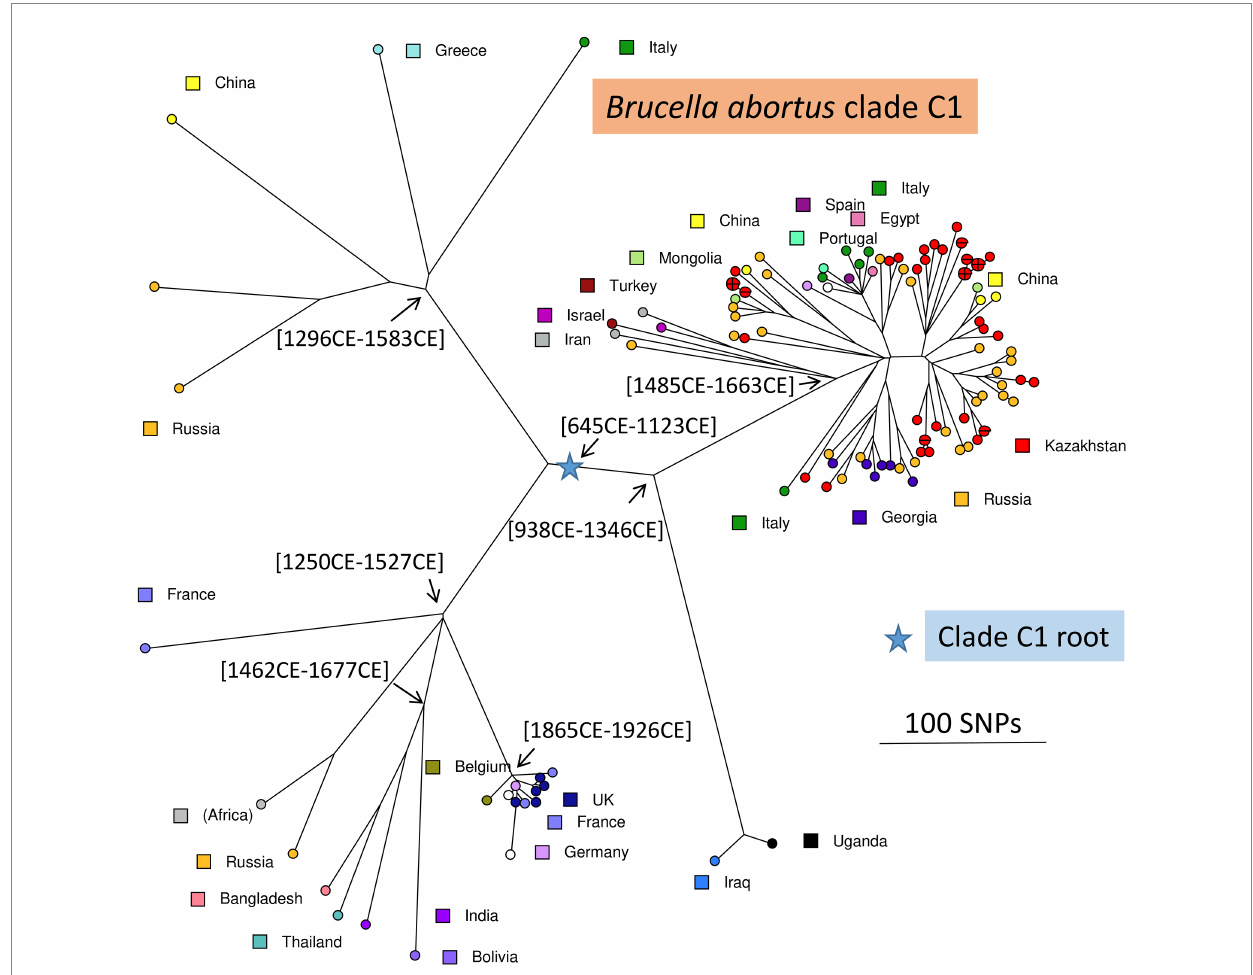
FIGURE 3 Brucella abortus subclade C1, position of the Kazakhstan strains within the global subclade C1 phylogeny. Maximum parsimony tree based on core genome SNPs. A total of 123 strains was used, including 77 selected strains of worldwide origins in addition to the 46 Kazakhstan strains. 5,446 SNPs were called by mapping on genome accession GCA_000740155 ( B. abortus strain Tulya). The size of the resulting tree is 5,487 SNPs (homoplasia 0.75%). Strains are colored according to country of origin as indicated. The blue star indicates the root of the phylogeny (branching point toward B. abortus clade B strain Tulya used as outgroup). Representative estimated divergence dates are indicated (CE, common